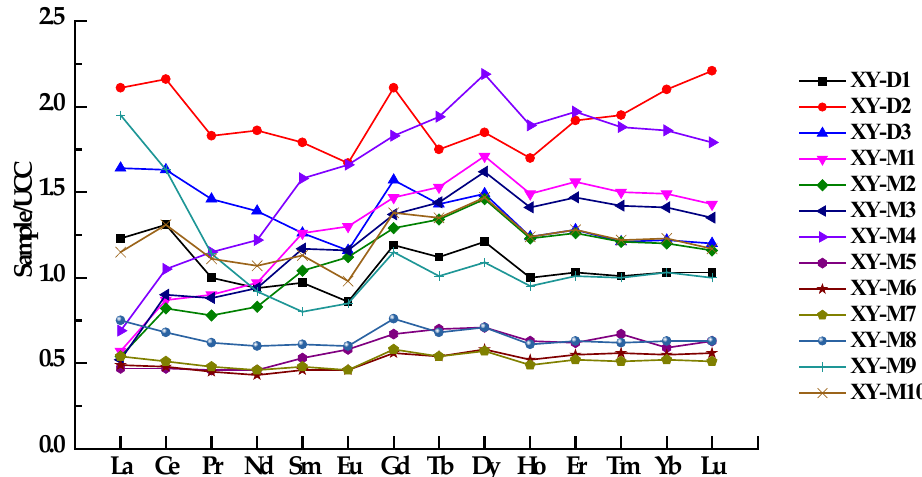
1 ΣLREY , total concentration of light REY elements (La, Ce, Pr, Nd and Sm); 2 Σ MREY, total con- centration of medium REY elements (Eu, Gd, Tb, Dy and Y); 3 Σ HREY, total concentration of heavy Table 6. Geochemical parameters of REY in the No. 9 coal and related roof samples from the REY elements (Ho, Er, Tm, Yb and Lu); 4 ΣREY , total concentration of rare earth elements and yt- Xinyuan mine. trium; 5 N, values normalized by the average concentration of REY in the upper continental crust [44]; coal samples; 6 Ce N /Ce N * = 2 × Ce N /(La N + Pr N ); 7 Eu N /Eu N * = 2 × Eu N /(Sm N + Gd N ). The REY enrichment type In the upper part of the No. 9 coal from the Xinyuan mine is M-type, while in the middle and lower part of the No. 9 coal, the REY enrichment types are L-type and H-type. The REY enrichment types in the roof samples are L-type and M- type. The Eu N /Eu N * values of the No. 9 coal range from 0.79 to 0.97, with an average of 0.91, showing slight negative Eu anomalies. Most of the negative Eu anomalies are inher- ited from the source rocks [45], indicating that the main source of REY is terrigenous de- bris. The average Eu N /Eu N * value of the roof samples is 0.82, suggesting a greater influence of terrigenous debris. The Ce N /Ce N * values of the No. 9 coal range from 0.99 to 1.29, with an average value of 1.11. Generally, there are no significant Ce anomalies in the No. 9 coal, while the Ce N /Ce N * values in the middle and lower part of the No. 9 coal are lower than that in the upper part. The negative Ce anomalies indicate that the lower part of the No. 9 coal is more affected by the seawater [46].